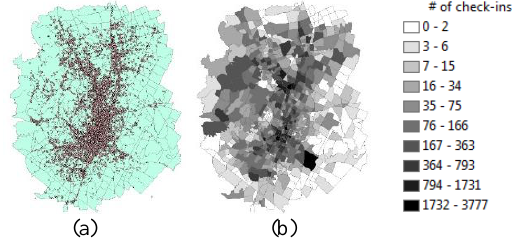
Figure 3. Foursquare check-ins locations and their spatial distribution among TAZs